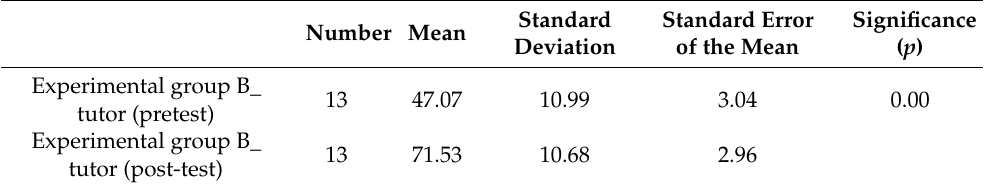
Table 6. Pretest and post-test t -test analyses of Experimental group B_tutor.